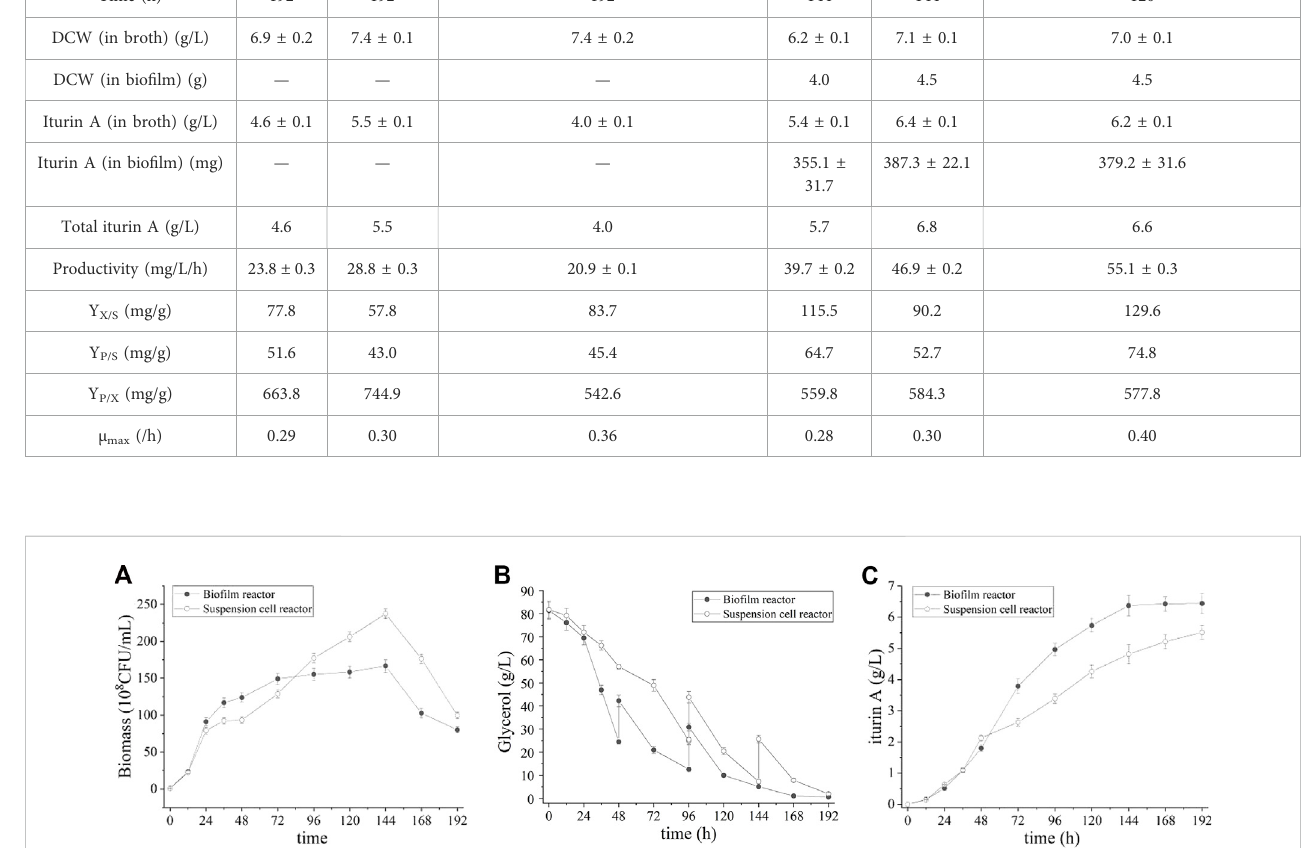
Frontiers in Bioengineering and